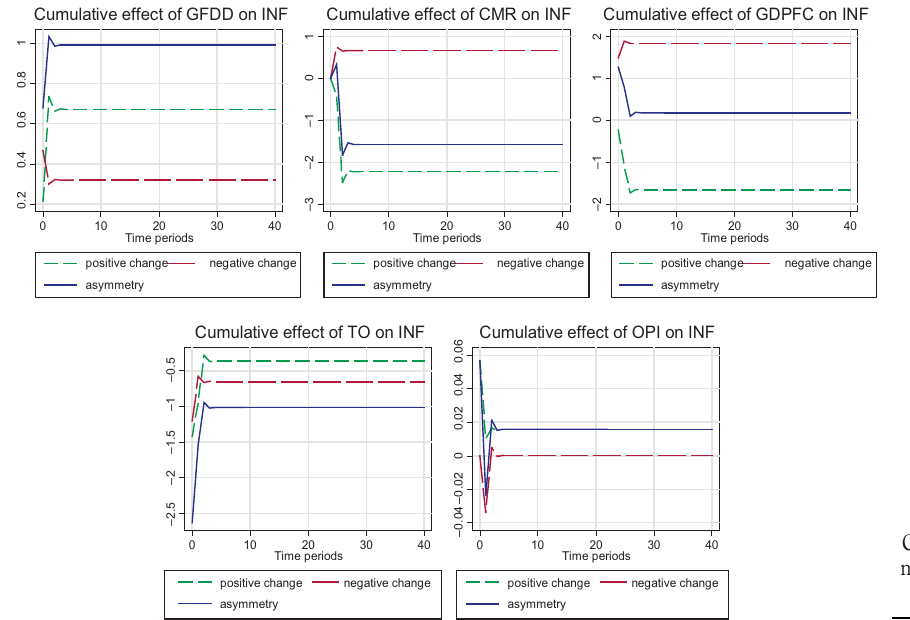
Figure 5. Cumulative dynamic multipliers for